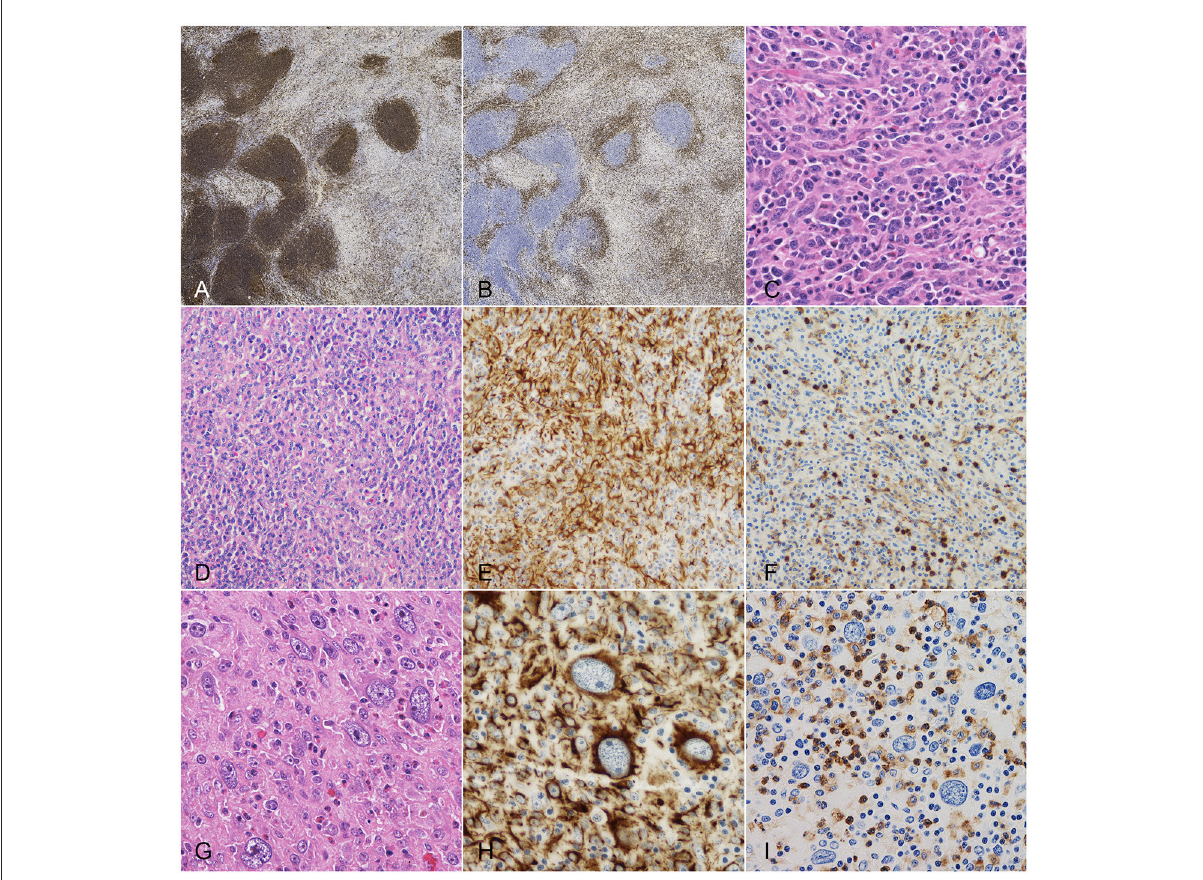
FIGURE1 Dog, spleen. Main histologic characteristics observed in splenic nodules with mixed stromal, histiocytic and lymphoid components. (A) CD20 immunohistochemistry (IHC): positivity of lymphocytes arranged in follicles and of fewer diffusely-distributed lymphocytes. (B) CD3 IHC: positivity of the diffuse lymphoid infiltrate. (C) Hematoxylin and eosin (HE): spindle cells with nuclear atypia and plasma cell infiltrate. (D) HE: stromal, histiocytic and lymphoid components irregularly admixed. (E) Same field after desmin IHC, highlighting stromal cells. (F) Same field after CD18 IHC, highlighting histiocytic cells. (G) HE: cells displaying karyomegaly. (H) Desmin IHC: strong cytoplasmic positivity of karyomegalic cells. (I) CD18 IHC: diffuse negativity of karyomegalic